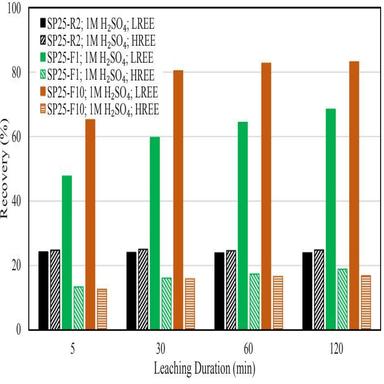
Leaching recoveries of LREEs and HREEs from the Guxu core samples using 1 M H2SO4.